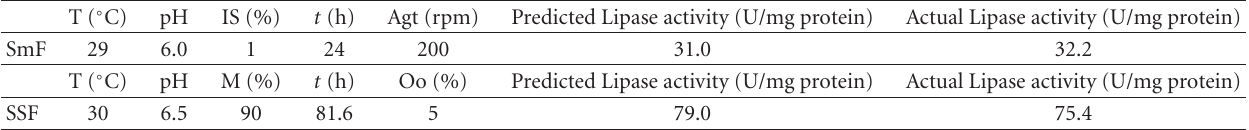
Table 4: Optimum conditions predicted by ANNs in SmF and SSF